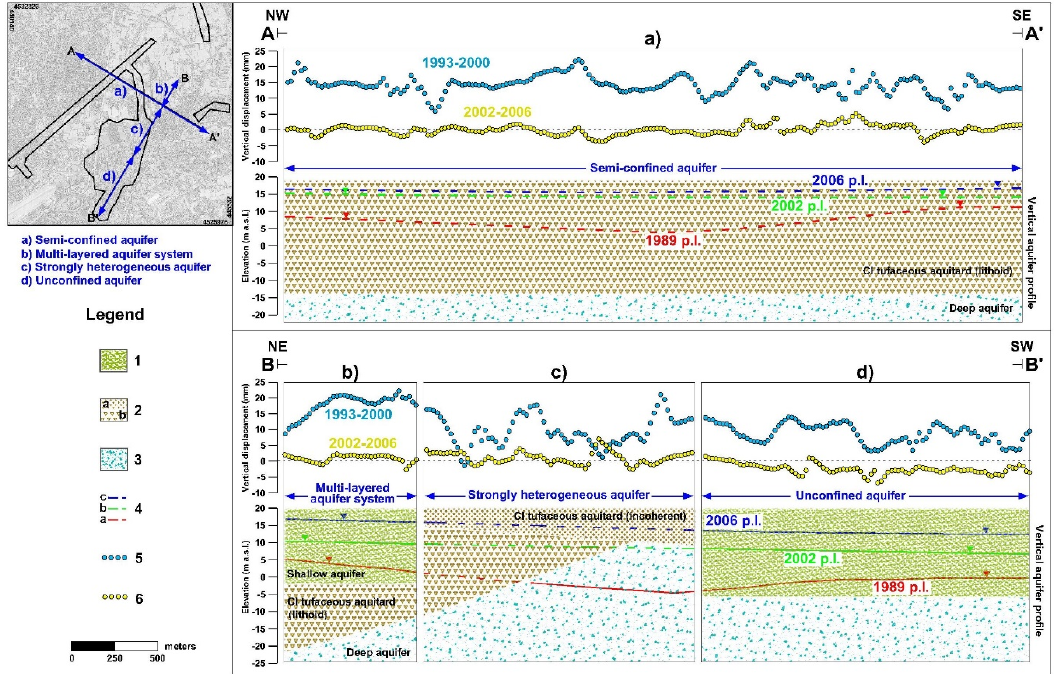
Figure 8. Groundwater levels and ground vertical deformations along the section traces A-A’ ( a ) and B-B’ ( b – d ). Legend: 1) shallow pyroclastic-alluvial-lacustrine complex; 2) Campanian Ignimbrite (CI) in incoherent (a) or lithoid (b) facies; 3) the deep pyroclastic sandy complex; 4) piezometric level (m a.s.l.) for the years 1989 (a), 2002 (b) and 2006 (c); 5) vertical displacement (mm) in the period 1993–2000; 6) vertical displacement (mm) in the period